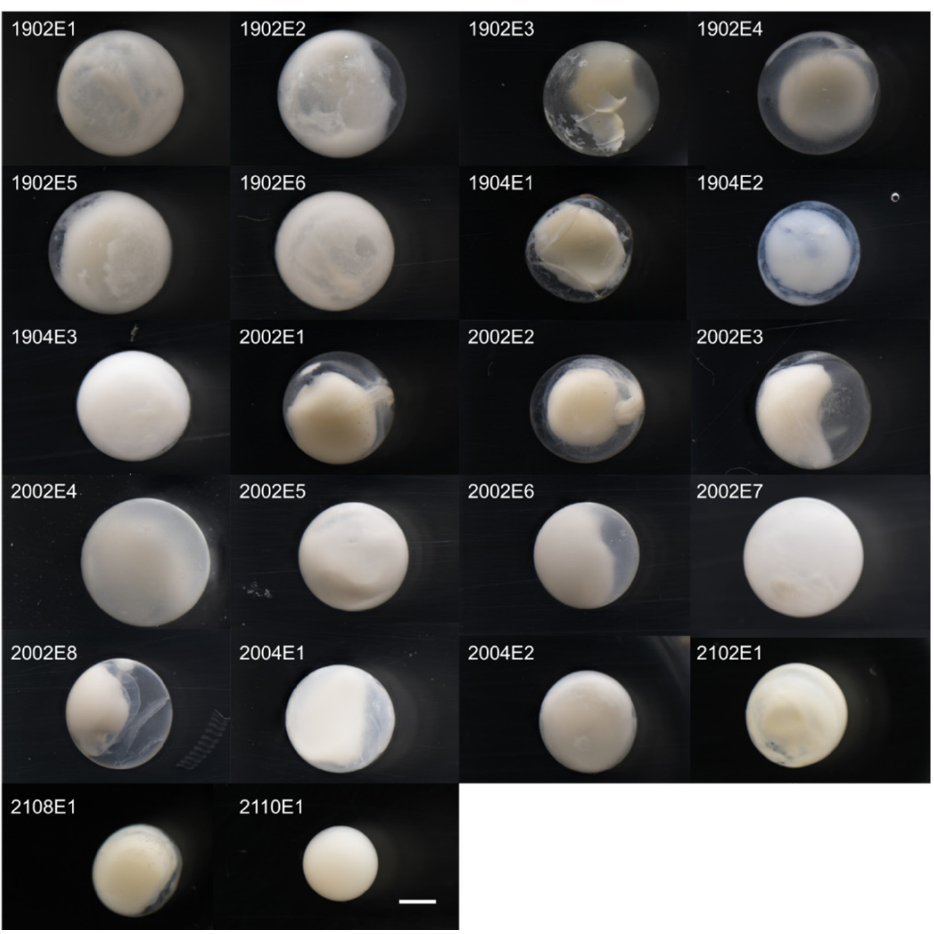
Figure 3. Pelagic eggs of two Trachipterus species preserved in 95% ethanol. 1902E1–2108E1, T. trachypterus ; 2110E1, T. jacksonensis . Scale bar, 1.0 mm.